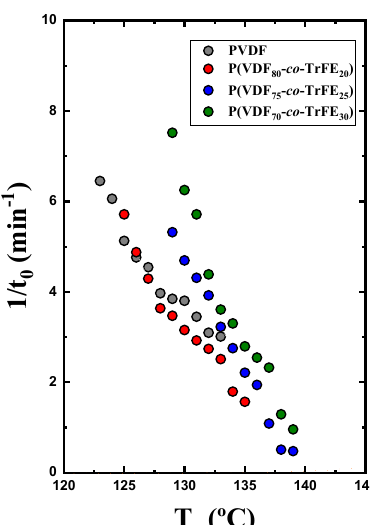
Figure 3. Representative PLOM images taken during an isothermal crystallization process of: ( a ) PVDF homopolymer at 140 °C, ( b ) P(VDF 80 - co -TrFE 20 ) at 140 °C, ( c ) P(VDF 75 - co -TrFE 25 ) at 139 °C, and ( d ) P(VDF 70 - co -TrFE 30 ) at 140 °C.